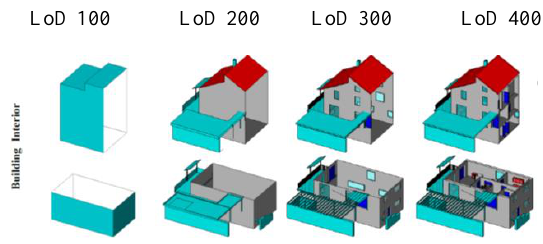
Figure. 3. A building model in IFC from LOD100 to LOD400 (Gröger & Plümer,